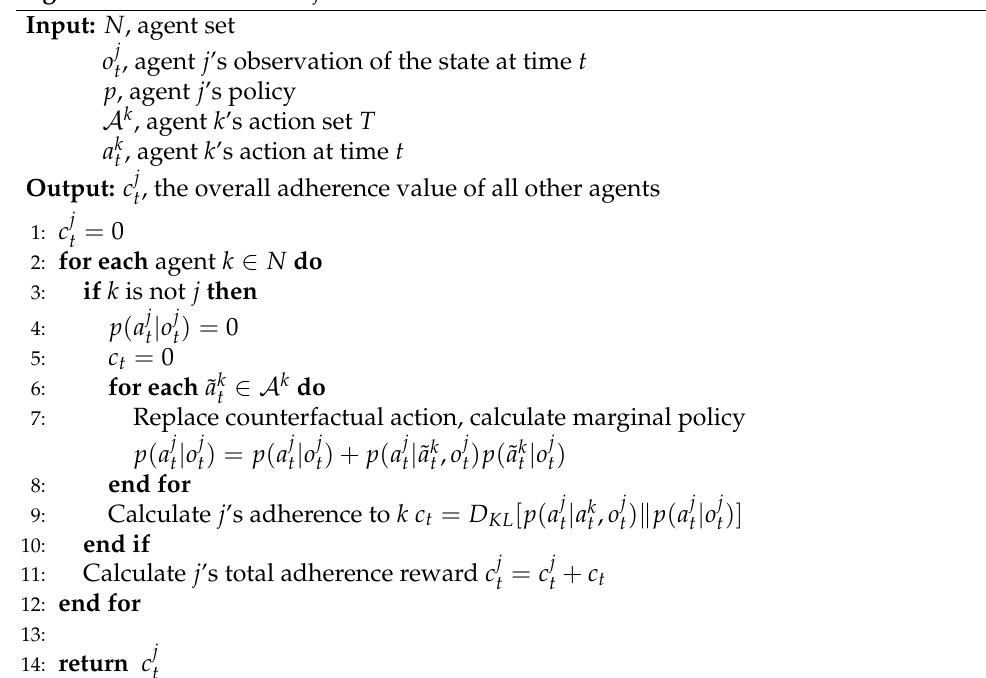
Algorithm 1 Evaluation of j ’s adherence